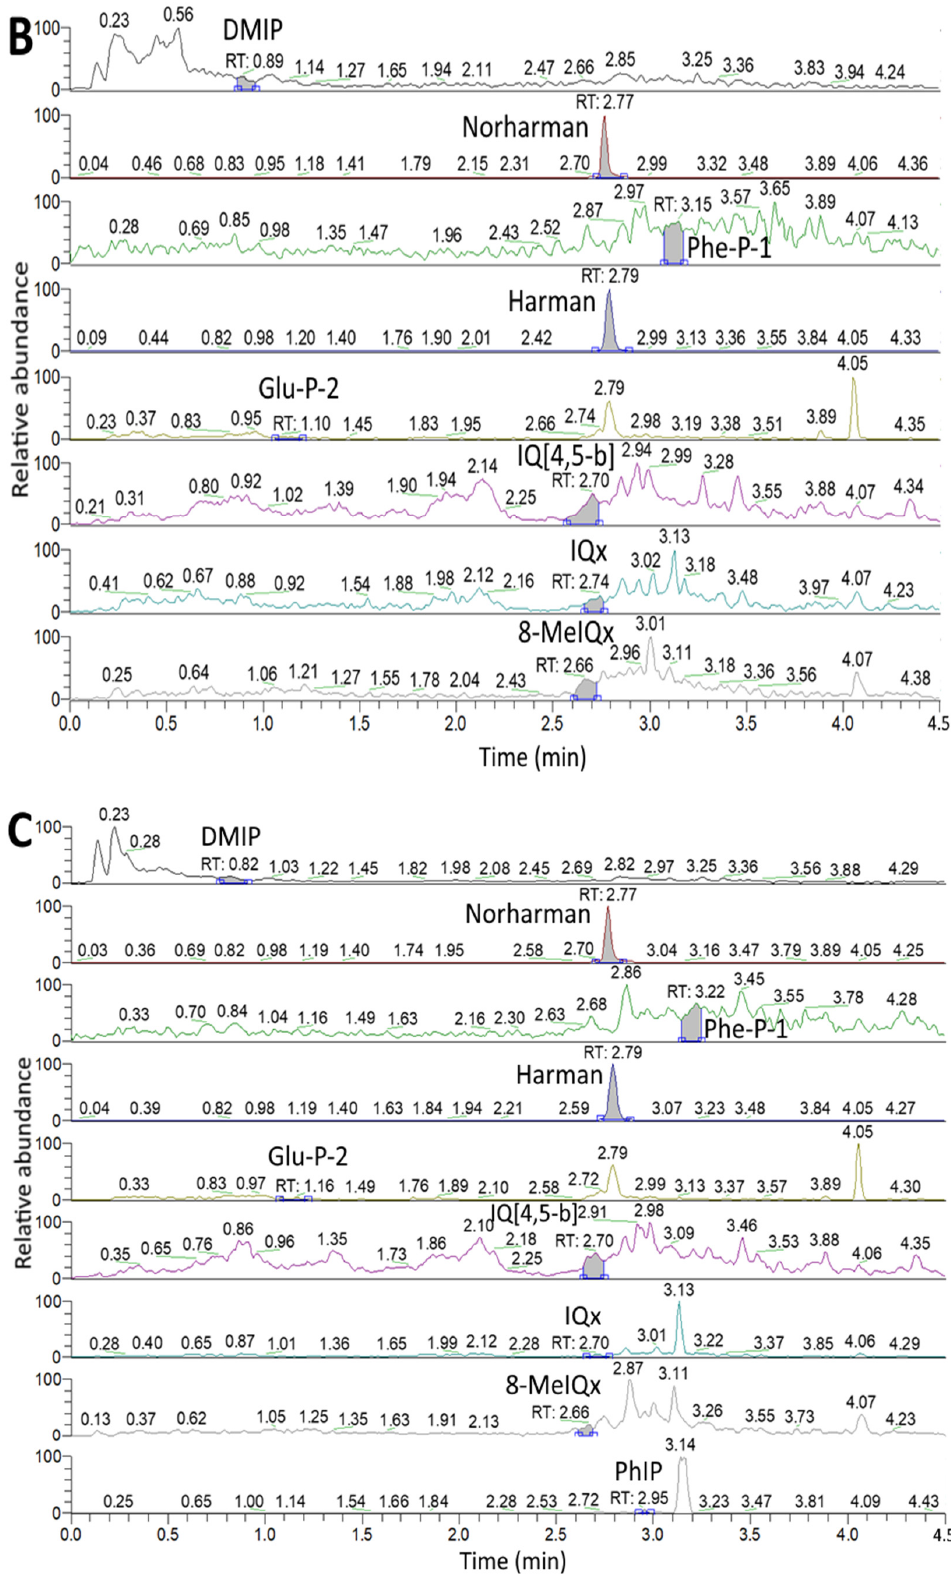
Figure 1. UPLC-MS/MS chromatogram of HAs in marinated pork after 24 h marinating ( A ), mari- nated pork with 0.5% cinnamon powder after 24 h marinating ( B ) and marinated pork with 0.5% green tea powder after 24 h marinating ( C ), as detected by SRM mode.